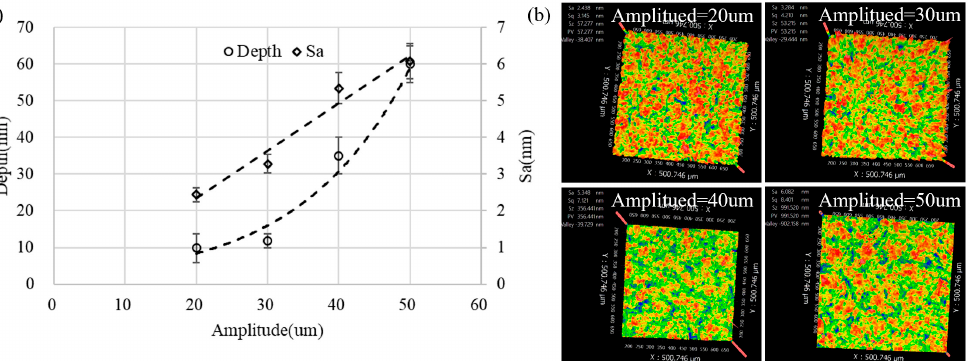
Figure 10. The influence of amplitude on the removal pit: ( a ) the depth and the bottom surface roughness and ( b ) the bottom surface morphology (gap = 0.15 mm, time = 300 s). roughness and ( b ) the bottom surface morphology (gap = 0.15 mm, time = 300